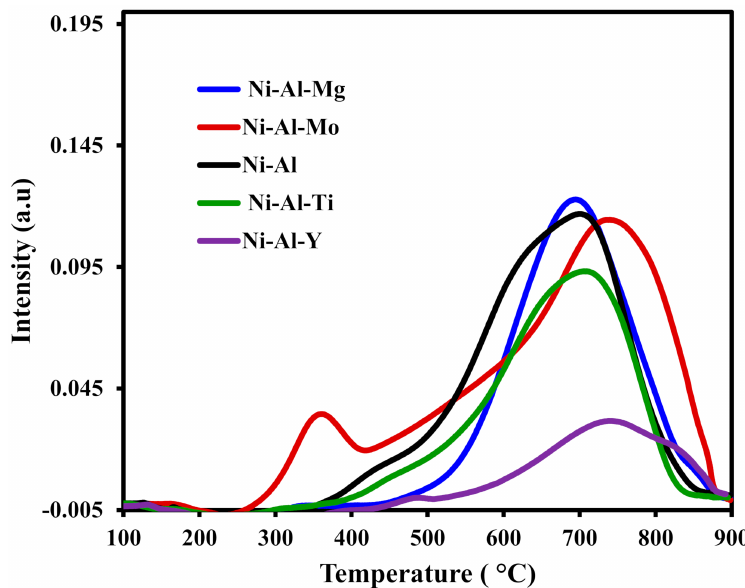
Figure 2. Temperature programmed reduction (TPR) profiles of the fresh Ni-Al-x (x = 0, Mo, Ti, Y, and Mg)